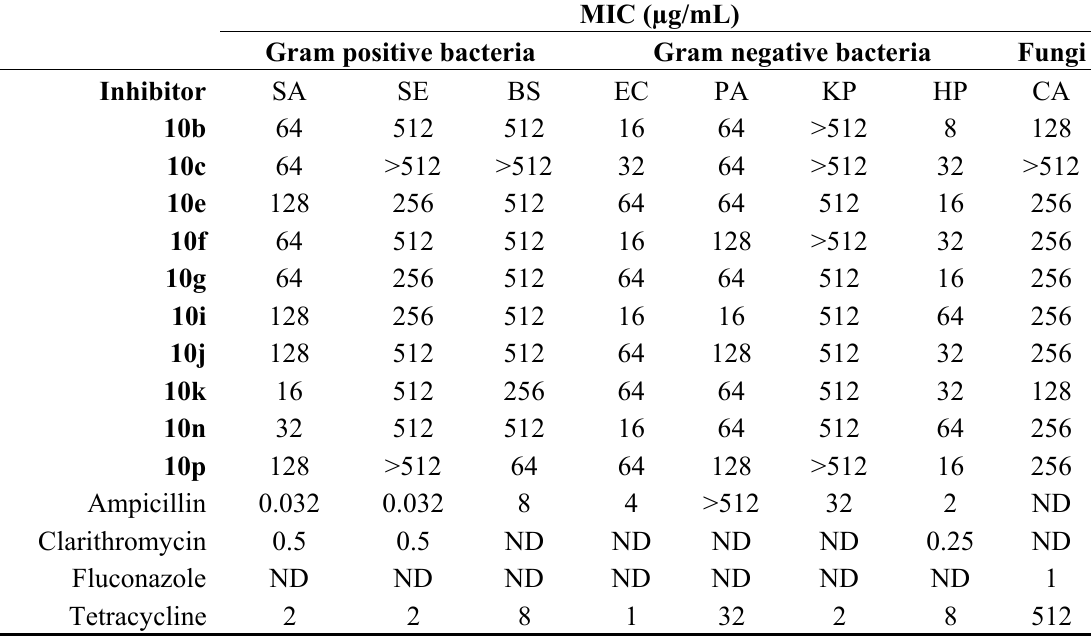
Table 1. Minimum inhibitory concentrations (MIC) of novel substituted ethyl 2-(quinolin-4-yl) propanoates for a range of